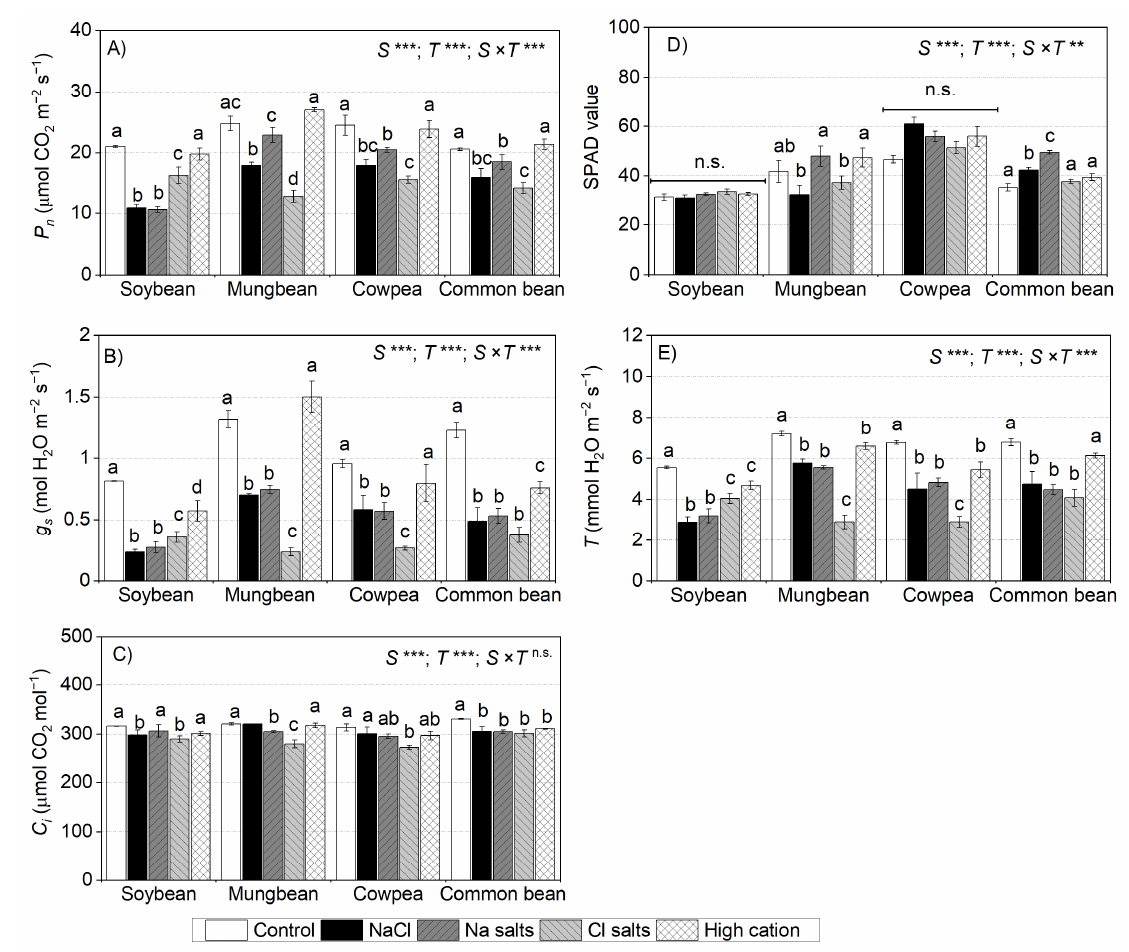
Figure 6. Net photosynthetic rate ( A ) ( P n ), ( B ) stomatal conductance ( g s ), ( C ) sub-stomatal CO 2 (internal CO 2 concentration ( C i ), ( D ) chlorophyll concentration (SPAD value), and ( E ) transpiration rate ( T ) of soybean, mungbean, cowpea, and common bean grown in control (non-saline), 100 mM NaCl, 100 mM Na + (without Cl − ), 100 mM Cl − (without Na + ), and high-cation negative control (K + , Mg 2+ and Ca 2+ equivalent to those in the 100 mM Cl − treatment) treatments. The salts used in the various treatments are given in Table 1. The treatments were imposed on 13-day-old plants, with gas exchange measured after 13–14 days of treatment (vegetative stage) between 09:00 and 15:00 at a photosynthetically active radiation of 1500 µ mol photons m –2 s − 1 , CO 2 concentration of 400 µ mol mol − 1 , leaf chamber temperature of 28 ◦ C, and 60–70% relative humidity. The values are means ± SE ( n = 4). Significant differences for treatment means within each species are indicated by different letters (a–c) ( p = 0.05). The probability levels for two-way ANOVA were used to compare species (S), treatment (T), and species × treatment interaction (S × T) effects (** p < 0.01, *** p < 0.001, and n.s. = not significant). Note: Different scales among graphs. For mungbean, at the vegetative stage, Cl − salts (without Na + ) had a significant adverse effect on P n (51% of the control), g s (17% of the control), and T (40% of the control) relative to NaCl (75%, 50%, and 79% of the control in P n , G s , and T , respectively) and Na + salts (without Cl − ) (90%, 56%, and 77% of the control in P n , g s , and T , respectively) (Figure 6A,B,E). There were small reductions in C i (<10%) in plants subjected to NaCl or Cl − salts (without Na + ) (Figure 6C). Mungbean subjected to Na + salts (without Cl − )